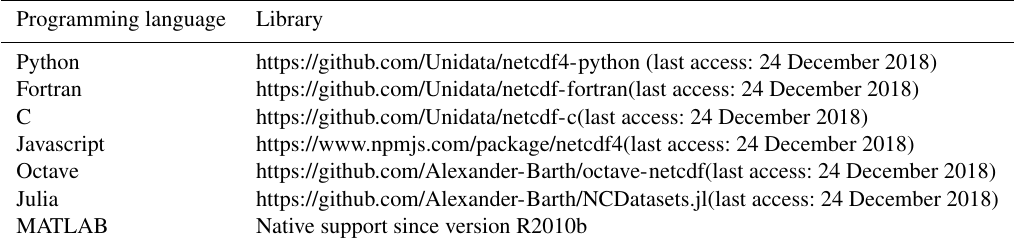
Table 6. NetCDF libraries for various languages. Programming